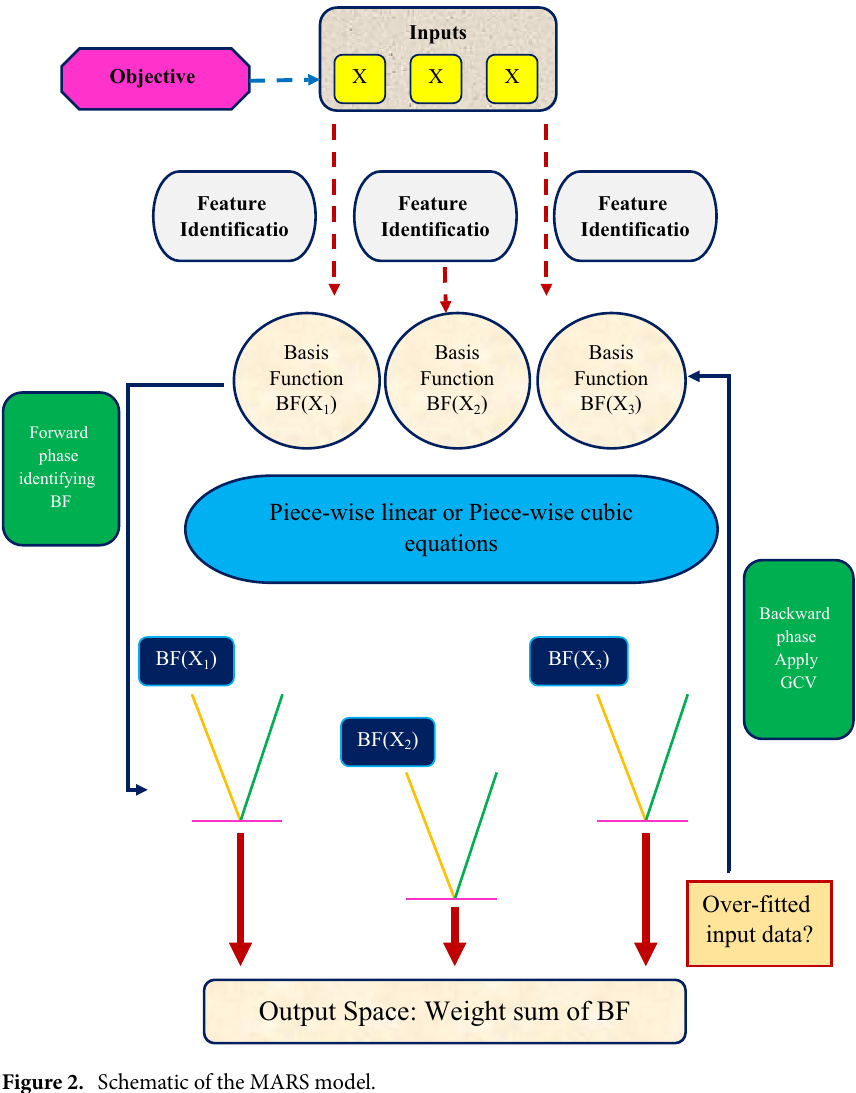
Figure 2. Schematic of the MARS